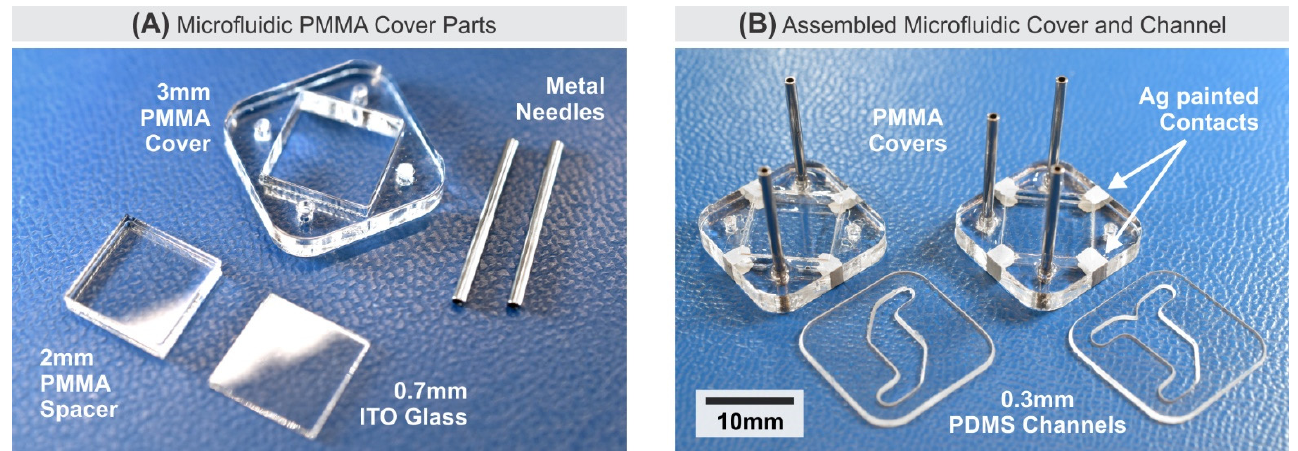
Figure 2. Microfluidic support system. ( A ) Unassembled parts of the microfluidic cover obtained and fabricated from low-cost off-the-shelf components and a laser cutter. ( B ) Two types of assembled microfluidic PMMA cover and PDMS channel.